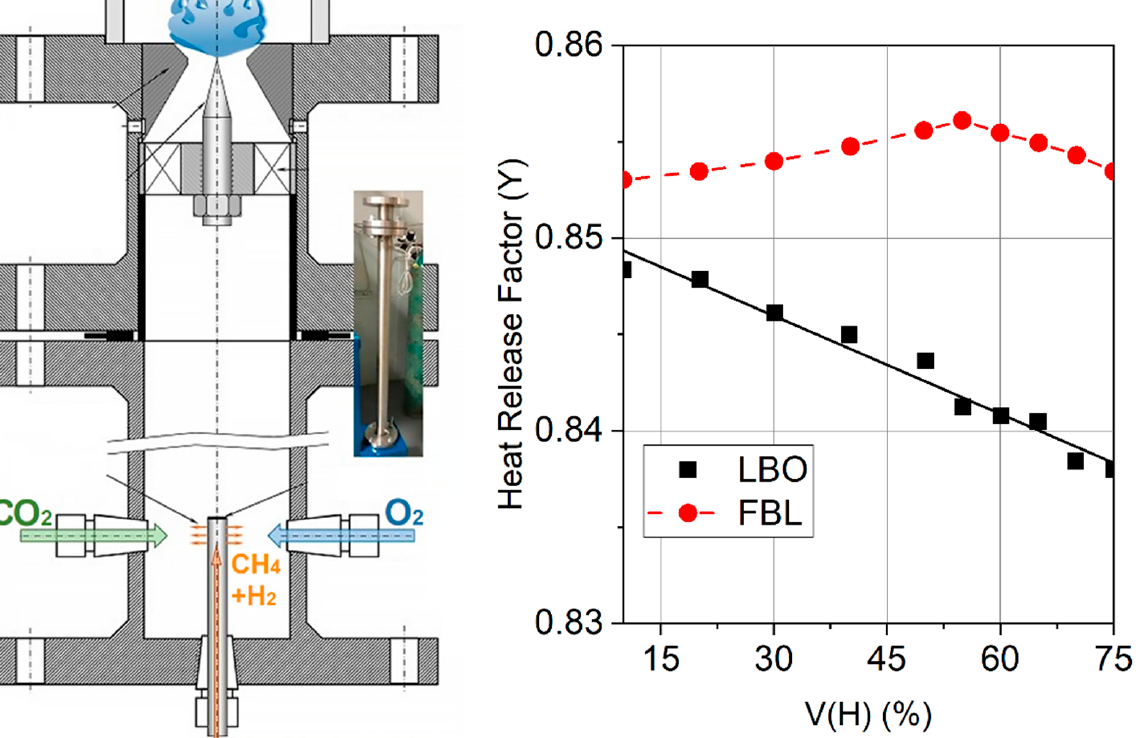
Figure 25. The range of burner stable operations with the hydrogen added to the fuel by volume. One of the main factors determining the expansion of the combustion limits for lean flame blowout with the addition of hydrogen is an increase in the critical flame deformation rate. Nemitallah [34] has shown that the critical strain rate significantly increased by over two times from ≈ 4300 s –1 for the combustion of pure methane to ≈ 9700 s − 1 to expand the boundaries of stable combustion (Figure